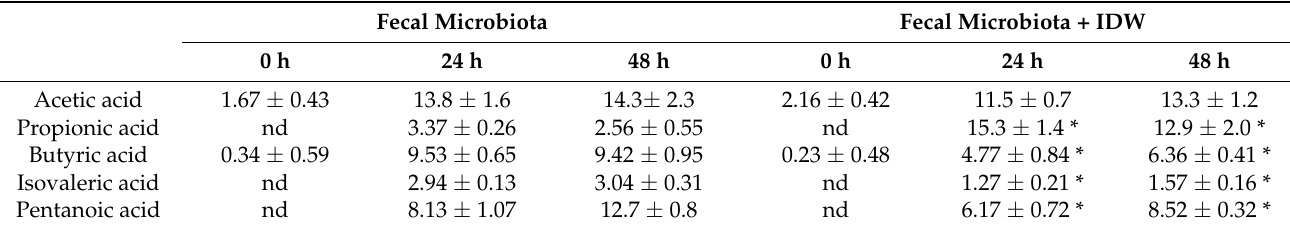
Table 3. Production of SCFAs ( µ M) during fecal fermentations in the absence and in the presence of intestinal-digested wine (IDW). Data are expressed as means ± SD of the concentration of SCFAs in the three